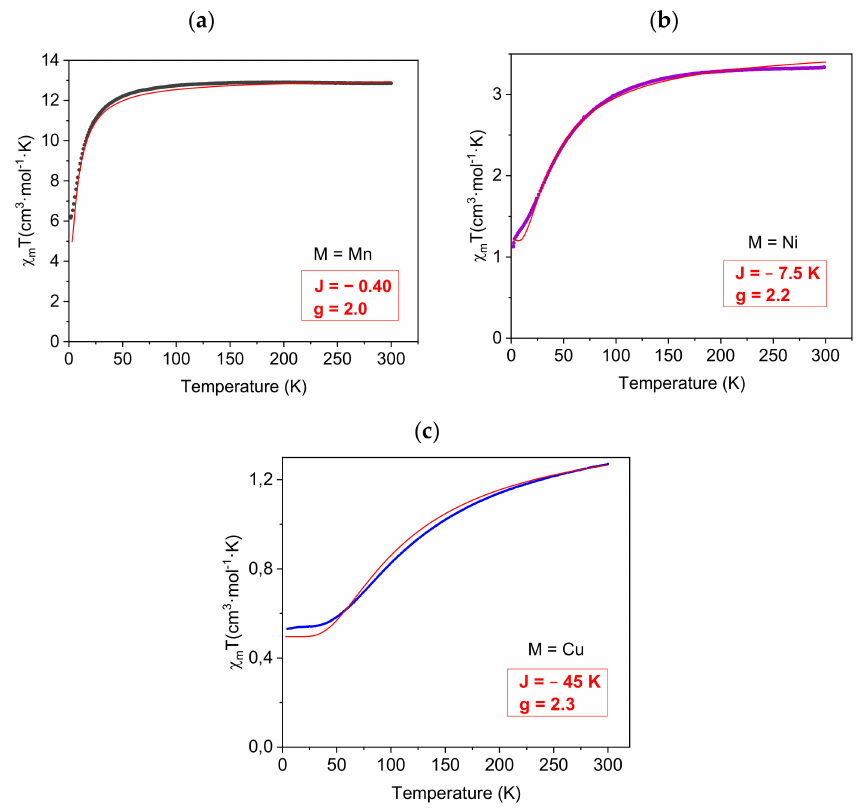
Figure 3. Plots of χ m T vs. T for Mn ( a ), Ni ( b ) and Cu ( c ), and their corresponding best-fit curves (red line) obtained with the MAGPACK